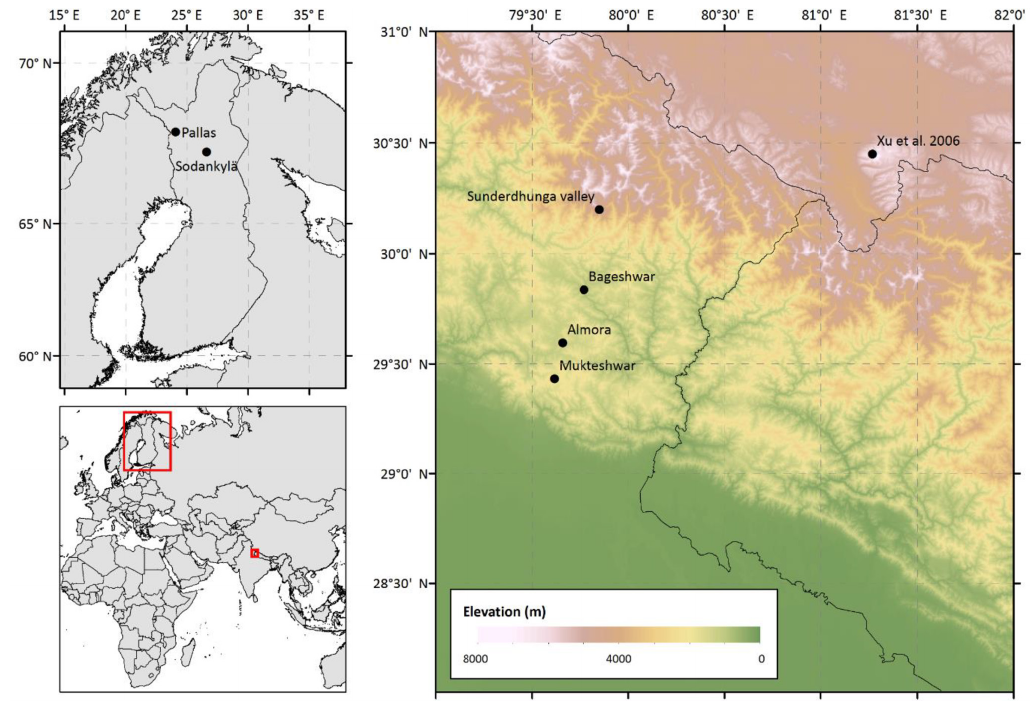
Figure 1. Map of sampling locations and sites discussed in